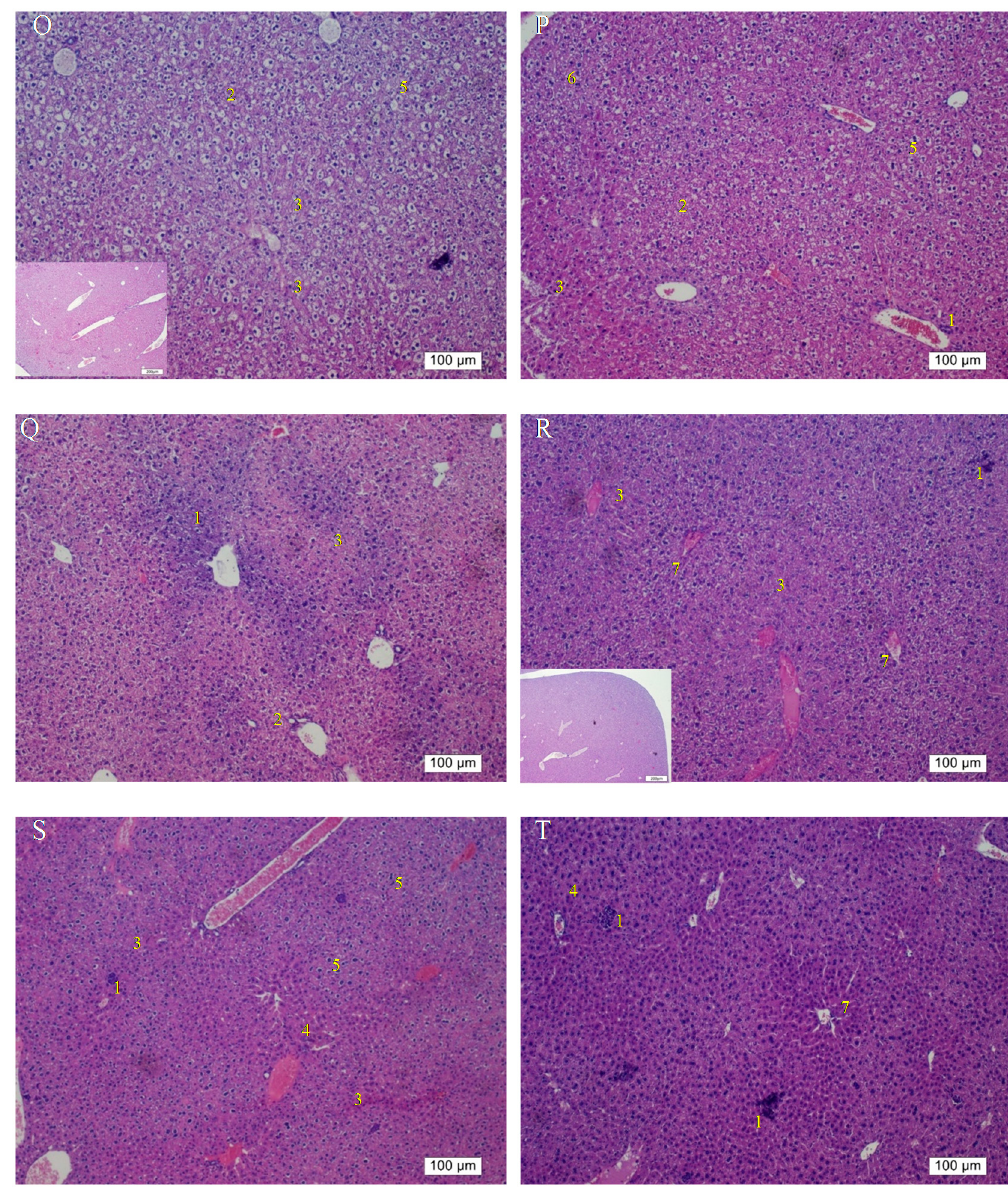
Figure 6. H&E staining and histopathological analysis of the liver in the experimental mice that received alcohol through two modes. Group A showed normal mice liver as Group B represented the mice received 3-week 30% alcohol feeding. Mice were given Asta-lipo or pure liposomes for 2 or 4 weeks prior to the 3-week 30% alcohol consumption (Groups C – F and K – N ) or 3-week 30% alcohol administration plus a second dose of 30% alcohol (Groups G – J and O – R ). Mice in Groups S and T received alcohol for 3 weeks without any administration for 2 and 4 weeks, respectively.